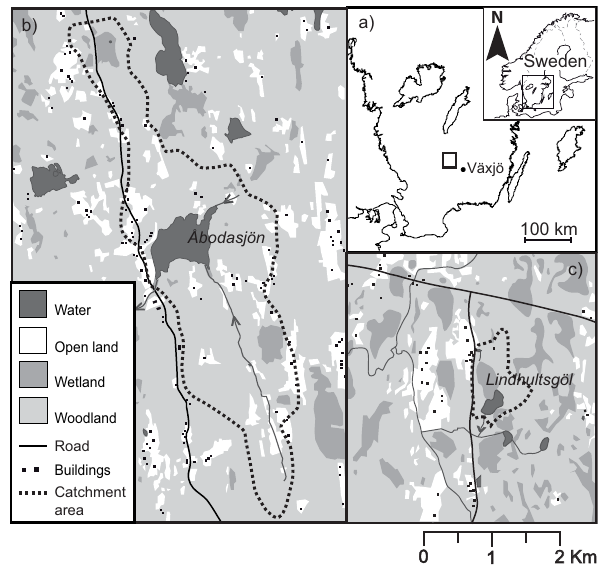
Figure 1. Location of study sites. (a) Map of Scandinavia and southern Sweden. The study area is marked by a square, and the closest city is Växjö. (b) , (c) Maps of the studied lakes and the present-day land cover in their